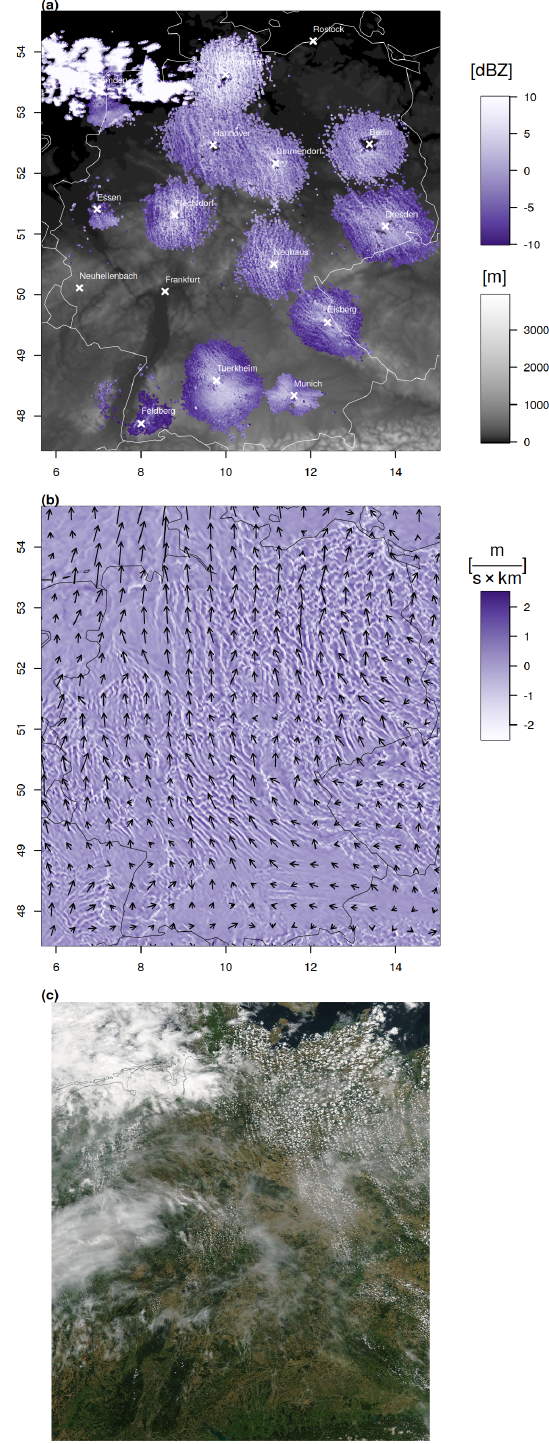
Figure 2. RADOLAN RX reflectivity in decibels relative to reflectivity (dBZ; blue) and orography in meters (grey shad- ing) (a) . COSMO-REA2 divergence (level 45 ≈ 200m) (b) and Aqua MODIS satellite image (c) on 29 July 2009 at